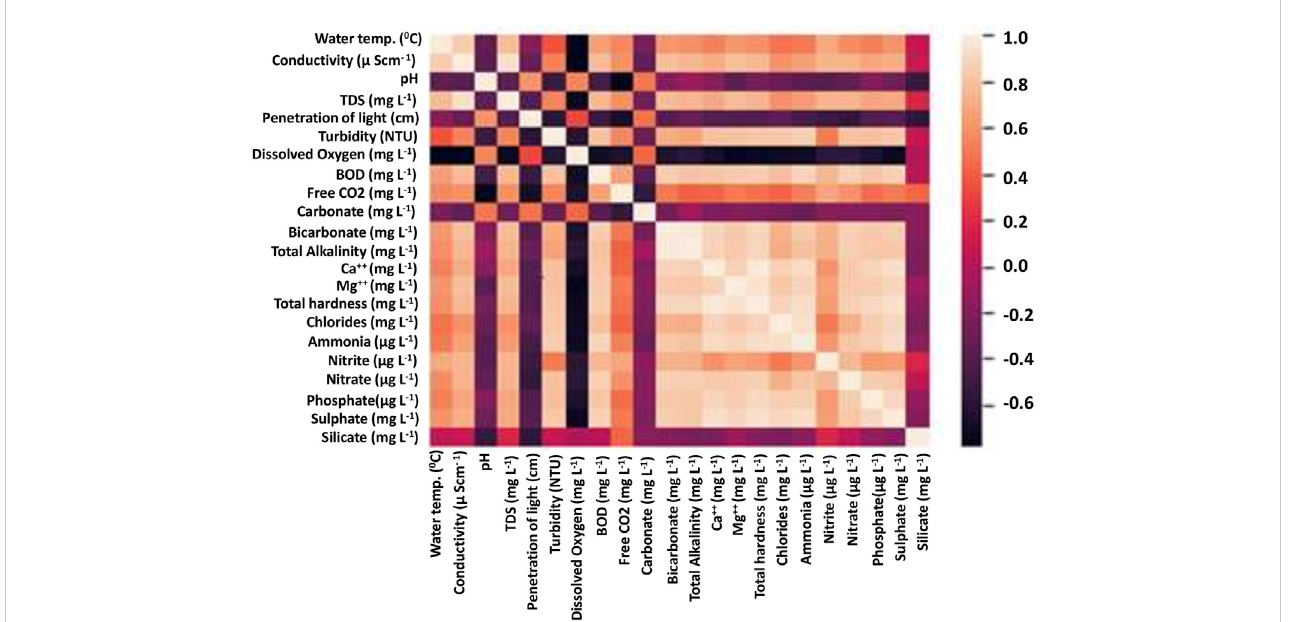
FIGURE 5 Correlation among various factors. The negative correlation depicts the inverse relationship (for instance, between dissolved oxygen and salt concentration).